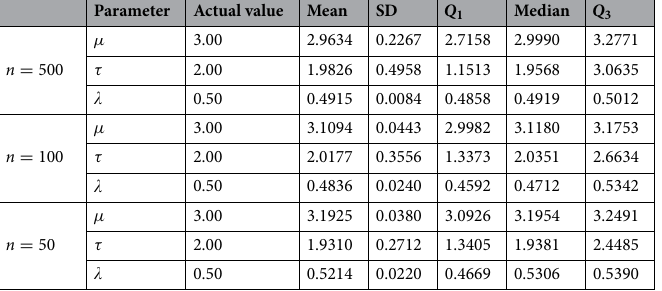
Table 2. Bayes estimates of parameters of SSVM with prior parameters, µ 0 = 0, τ 0 = 0.01, α = 4, β = 2, ξ = 0.5 and σ = 0.01